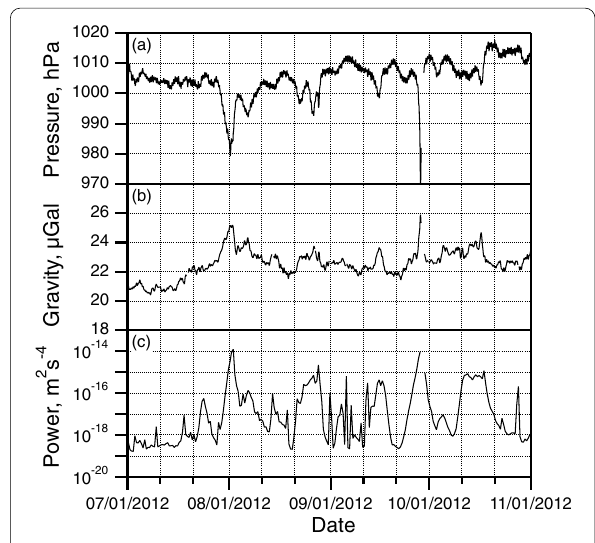
Fig. 3 Apparent correlation between noise level and gravity. a Atmospheric pressure. b Gravity residual. c Power of background noise in the frequency range 0.15–0.25 Hz calculated from gravimeter records. Notice that gravity changes are partly similar to the noise level, especially when the pressure is